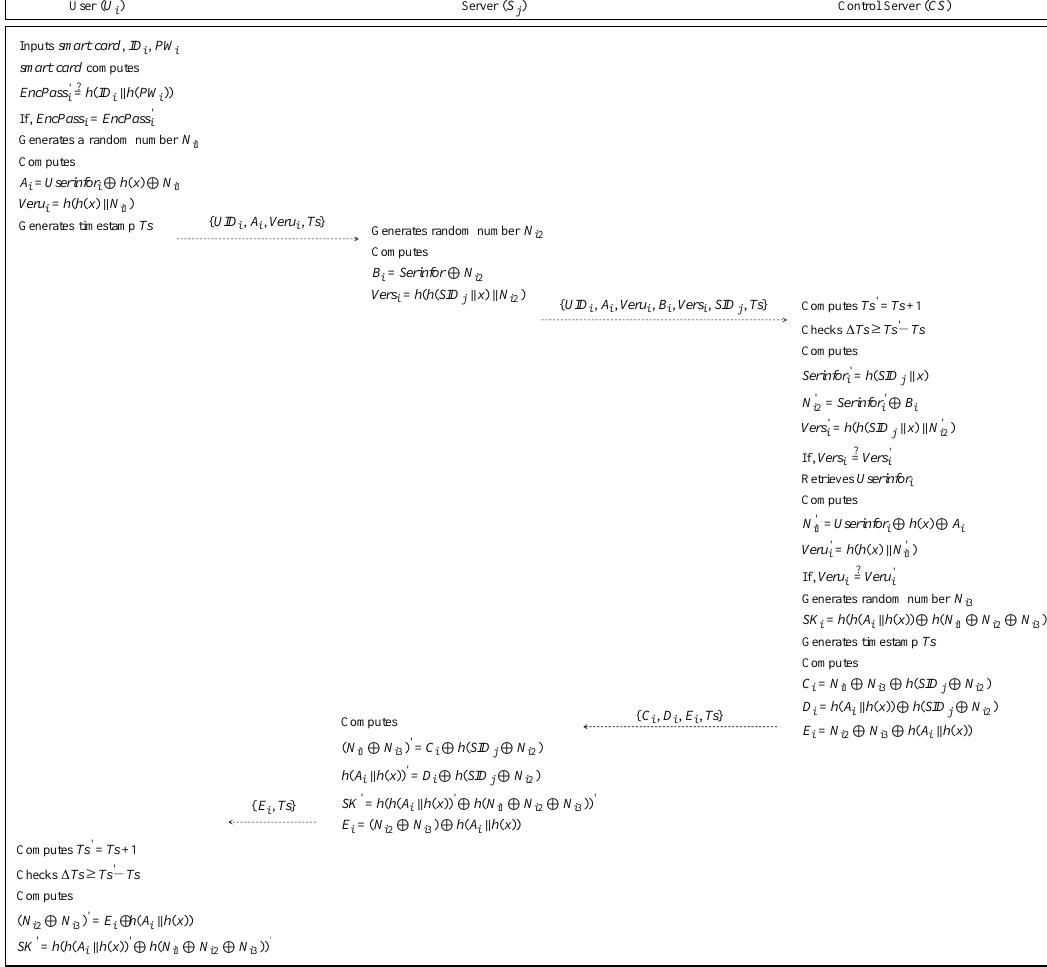
Figure 3. Login and authentication phase of Bae et al.’s